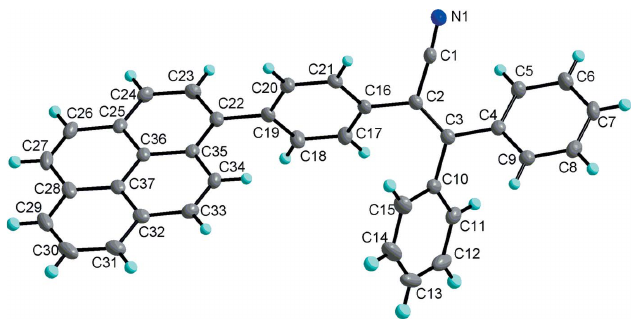
Figure 1 The molecular structure of the title complex, with 30% probability displacement ellipsoids.